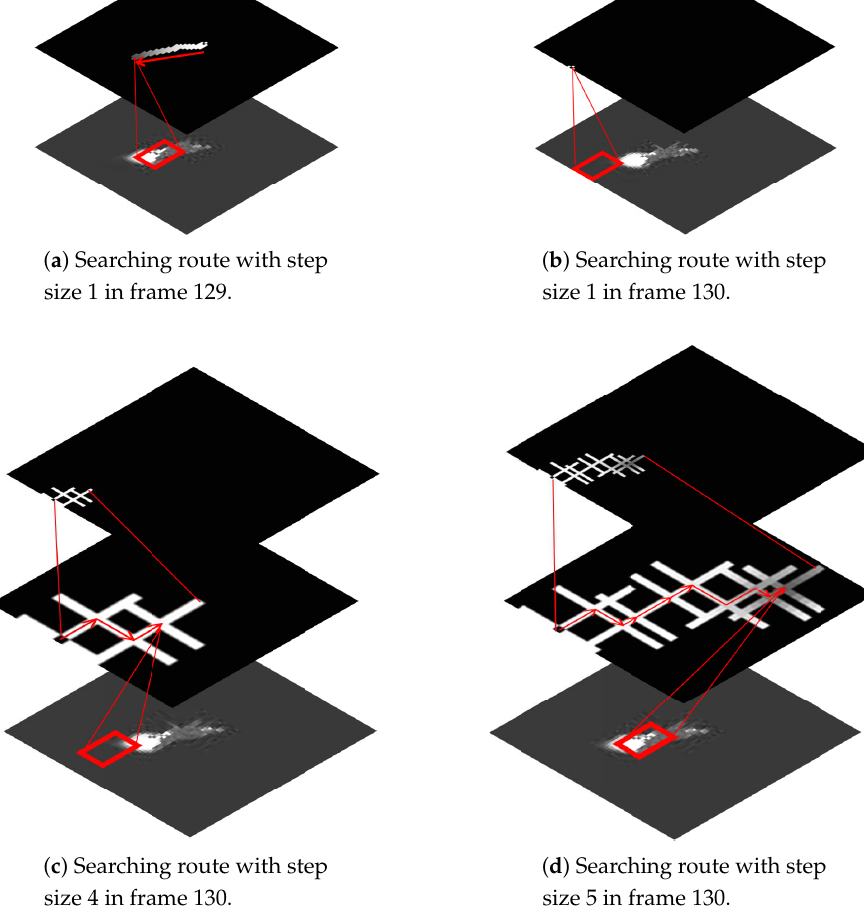
Figure 11. Searching-route